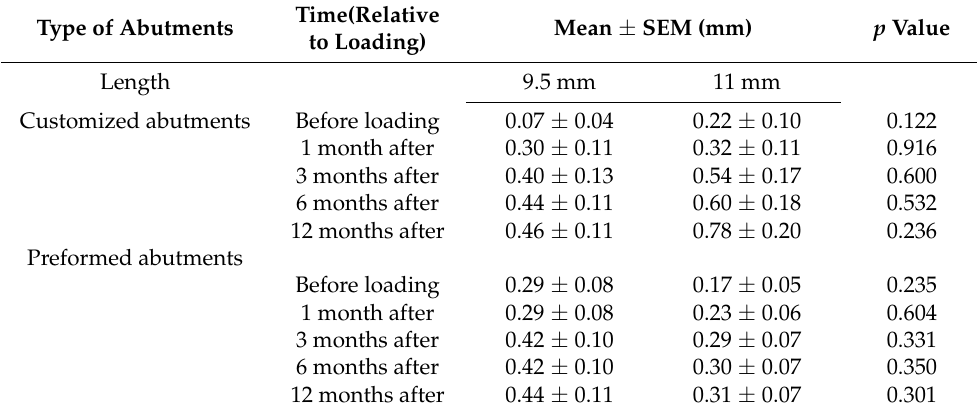
Table 11. Comparison of groups by implant length. SEM, standard error of measurement. Type of